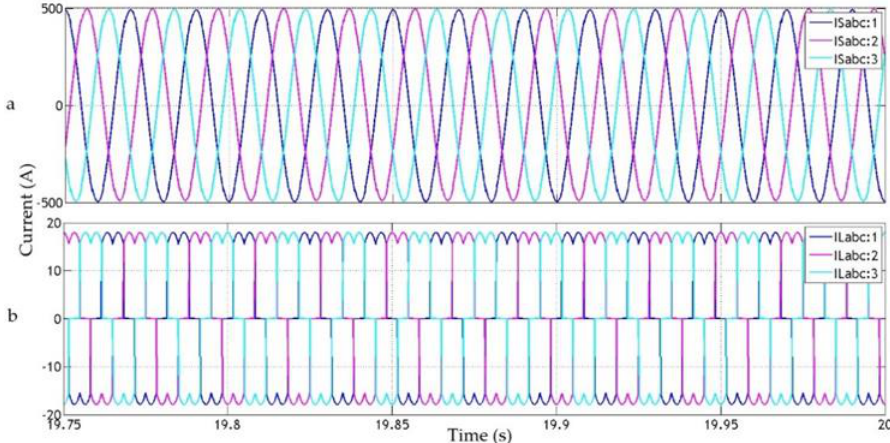
Figure 16. After compensation current ( a ) source; ( b ) load.